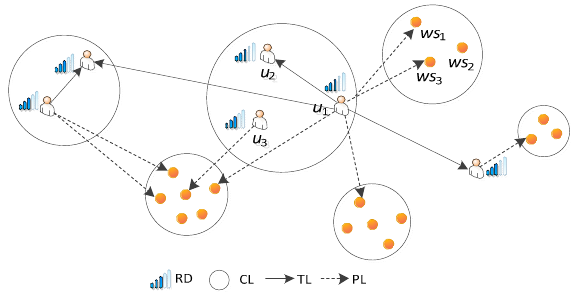
Figure 5. Instance of a formalized social link.